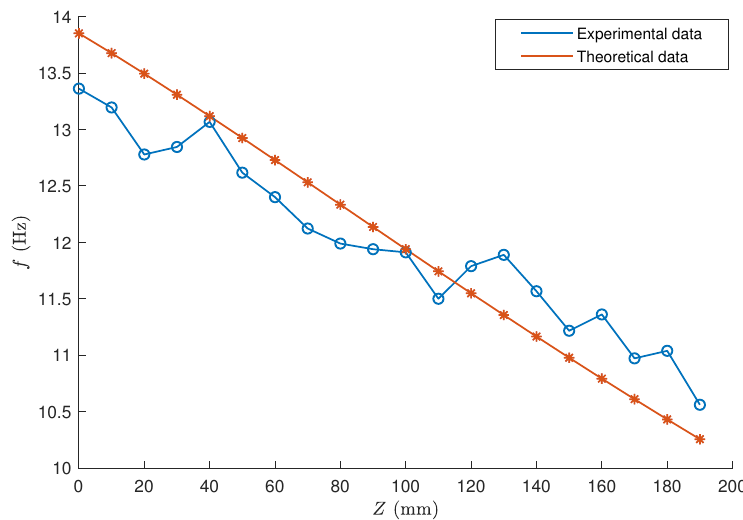
Figure 10. The first mode of the Anycubic i3 Mega 3D